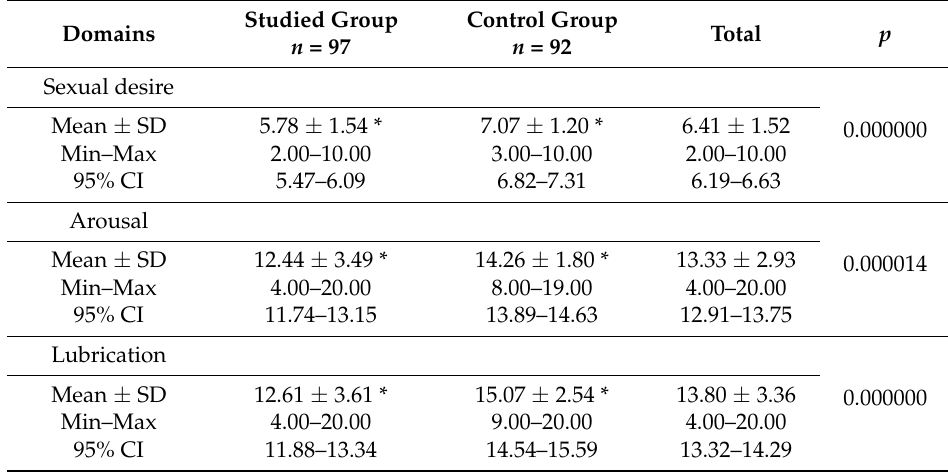
The evaluation of sexual function in the studied and control groups—FSFI scale. (*—statistically